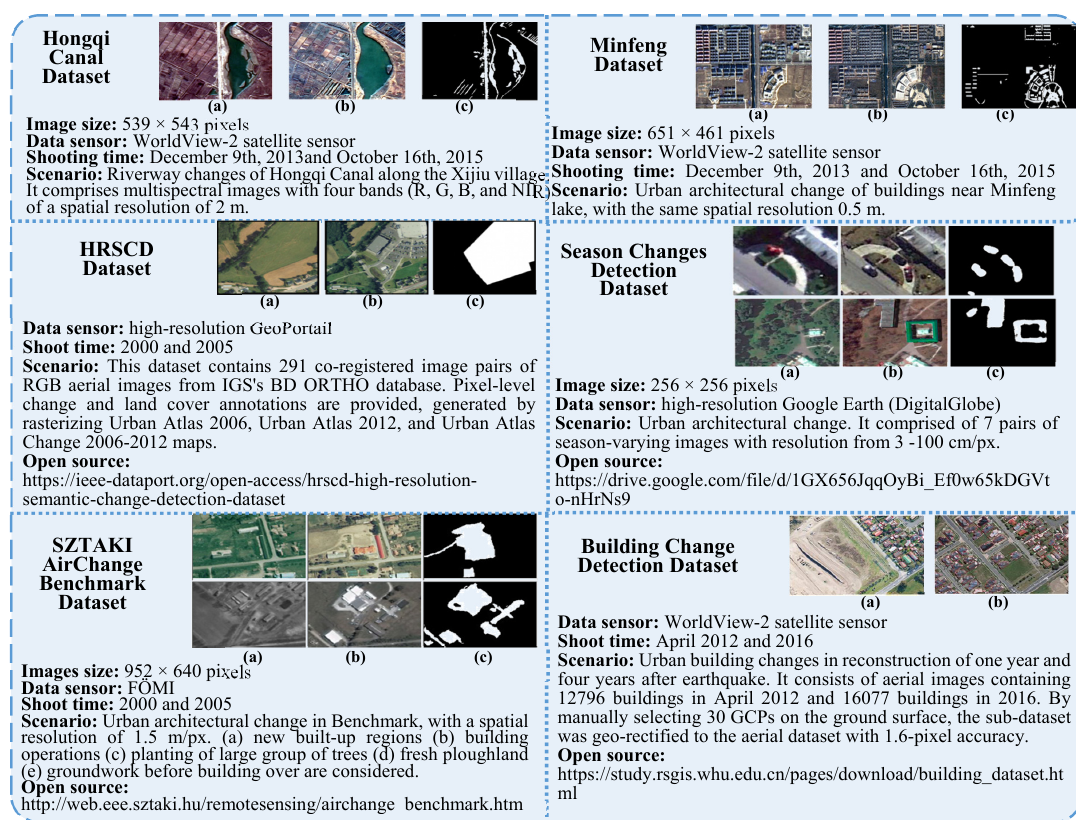
Figure 6. Dataset introduction of multispectral images in local-area applications.